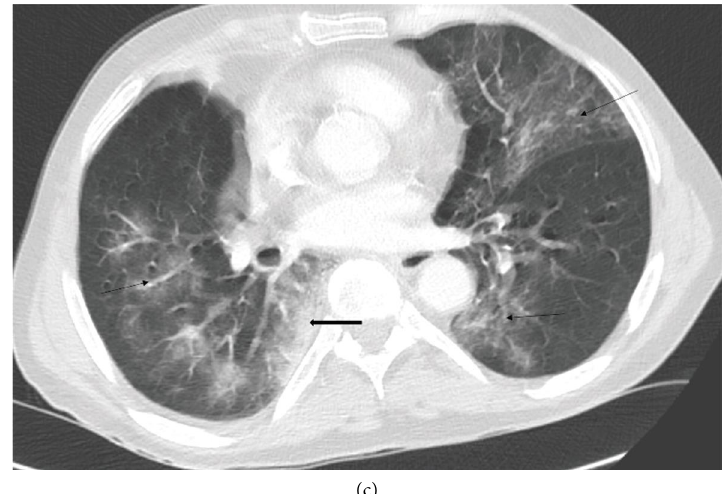
Figure 2: (a) Axial contrast enhanced CT image with mediastinal window settings demonstrating consolidated RUL (thick black arrow) with foci of cavitation, one of which is indicated with the thin black arrow. Mildly enlarged pretracheal-retrocaval lymph node (thin white arrow). (b) Contrast-enhanced CTreconstruction through the right hemithorax with mediastinal window settings. Expanded, consolidated RUL with depression of the oblique fssure indicated by a thin white arrow. Collapsed RML demonstrating enhancement, contrasting with the hypo-enhancing consolidated RUL (thin black arrow). Small right pleural efusion (thick white arrow). (c) Axial CT image with lung window settings demonstrating bilateral multilobar foci of ground-glass density (thin black arrows) and a focus of RLL paravertebral subpleural consolidation (thick black